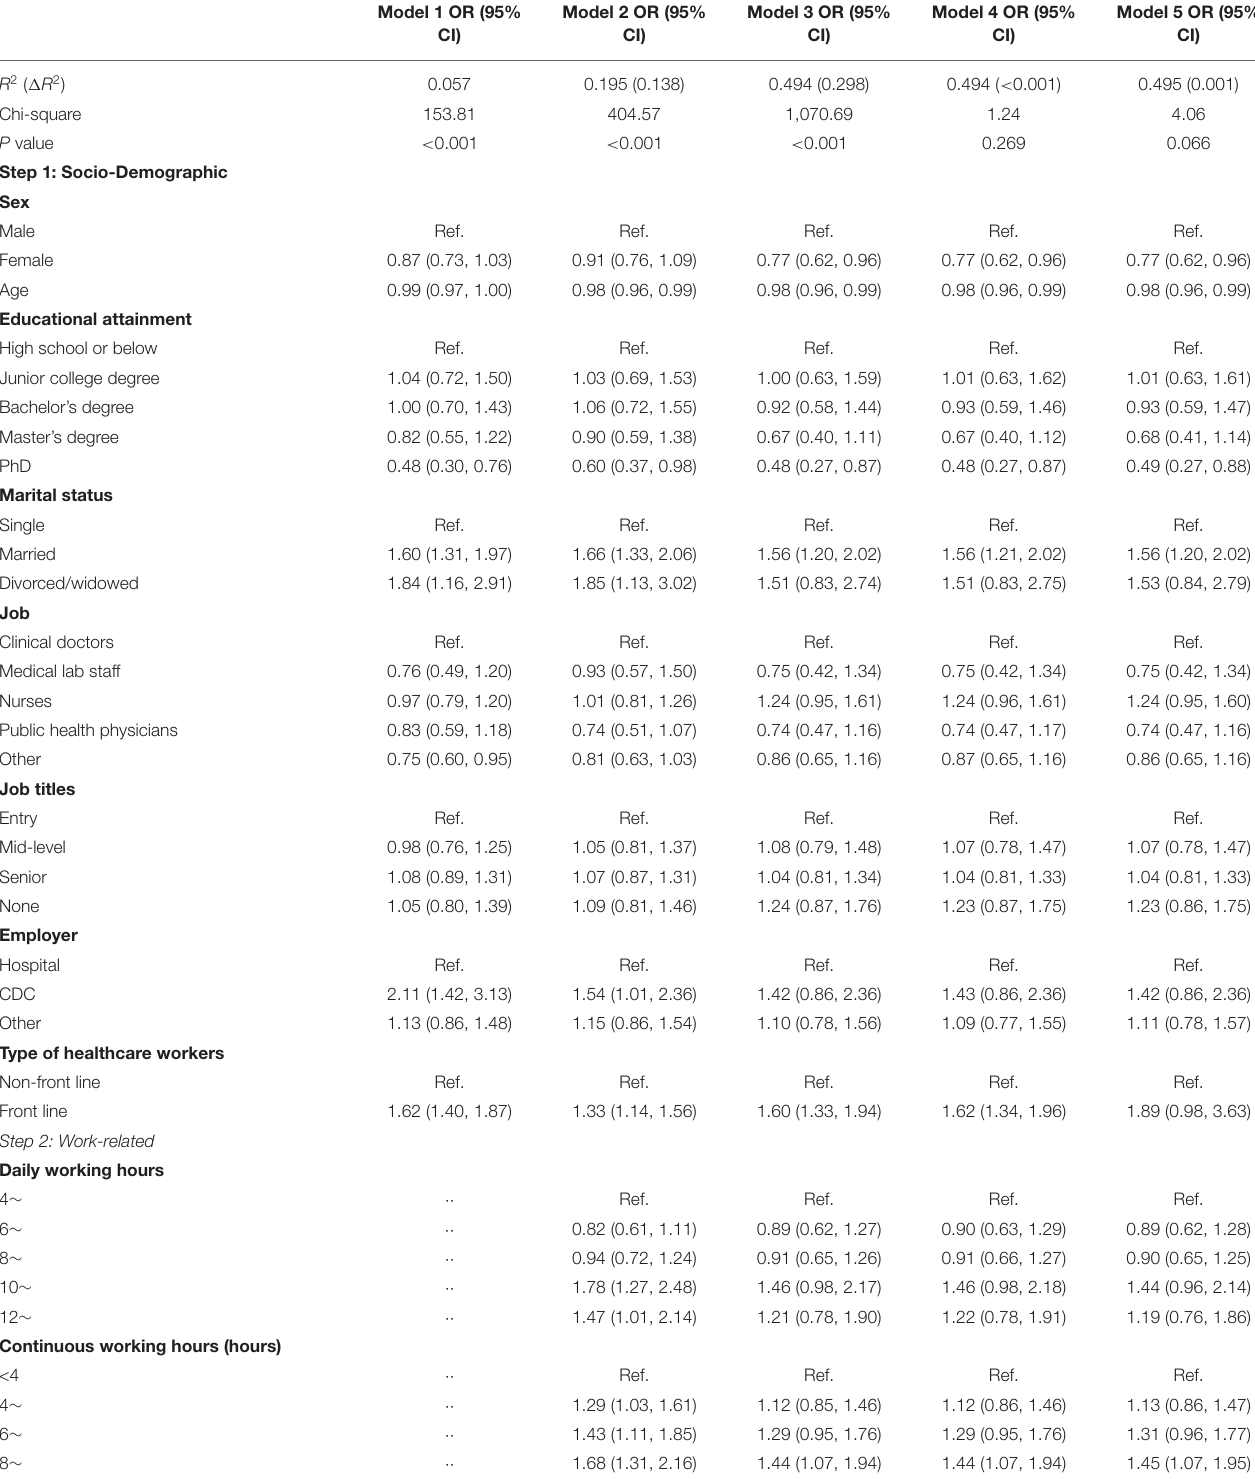
TABLE 2 | Logistic regression of factors correlated with insomnia among healthcare workers during the COVID-19